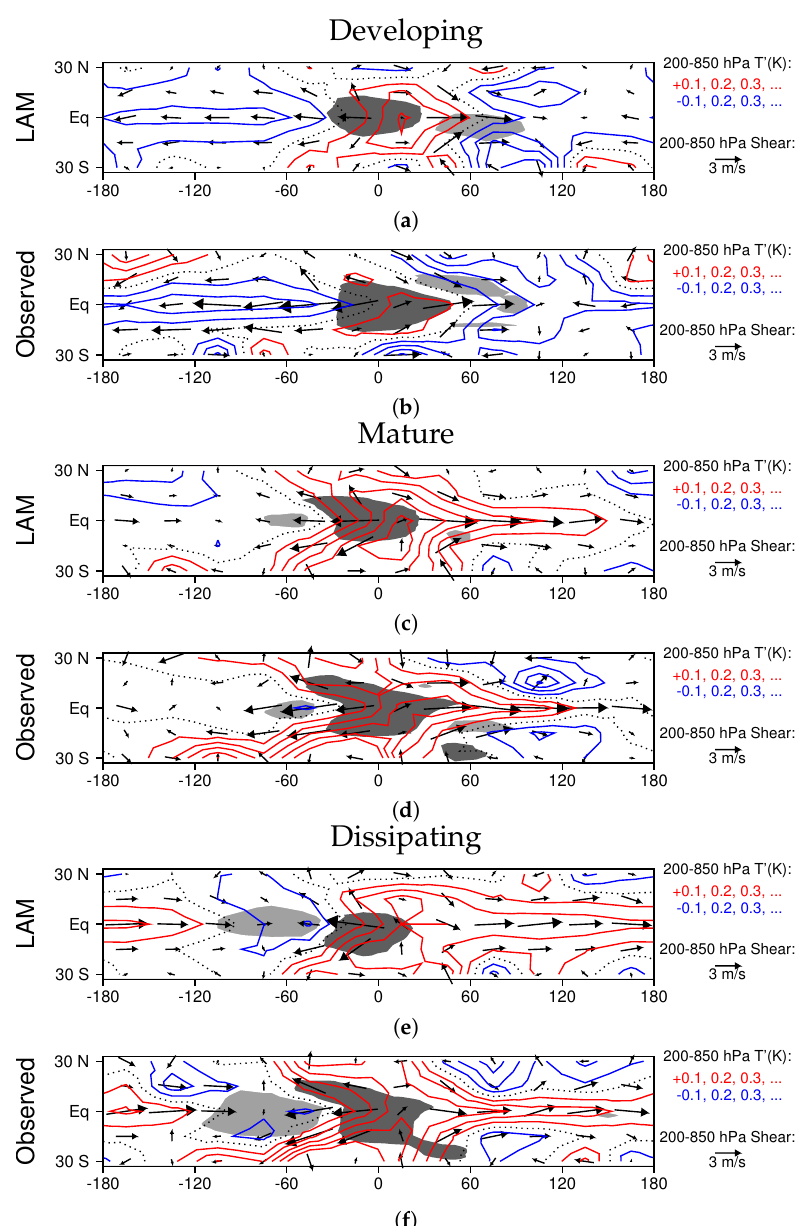
Figure 6. Composite MJO horizontal structure for ( a , b ) developing, ( c , d ) mature, and ( e , f ) dissipating stages. Dark shading indicates rainfall perturbations of greater that 1 mm/day, and light shading indicates perturbations of less than 1